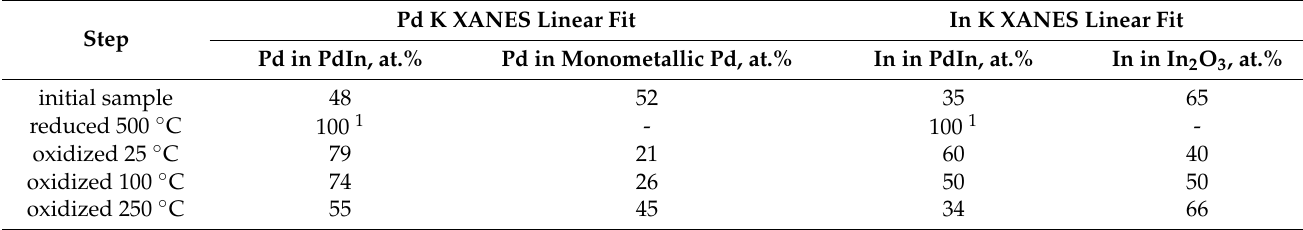
Table 2. Estimates of the Pd and In fractions in different phases from the linear combination fit of XANES spectra. Pd K XANES Linear Fit In K XANES Linear Fit Step Pd in PdIn, at.% Pd in Monometallic Pd, at.% In in PdIn, at.% In in In 2 O 3 ,